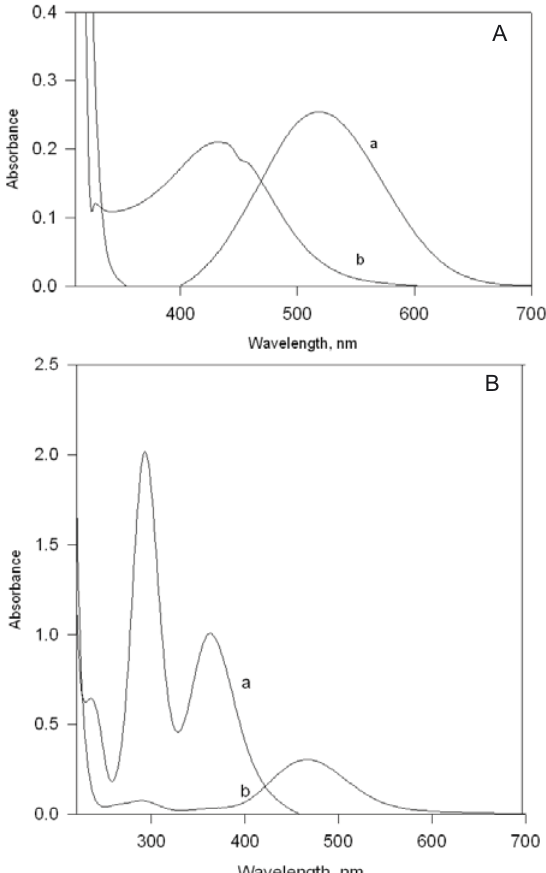
Figure 1. Absorption spectra of charge transfer complex of (Aa) 2×10 -4 M SU with 1×10 -3 M p-CA and (Ba) 4×10 -5 M SU with 4×10 -4 M iodine in acetonitrile, and (Ab and Bb) reagent blank against acetonitrile